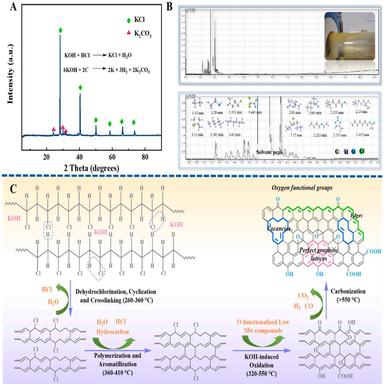
(A) XRD patterns of unpurified solid products after pyrolysis. (B) Liquid by-products examined using GC–MS. (C) Proposed mechanism for the conversion of PVC into carbon materials.